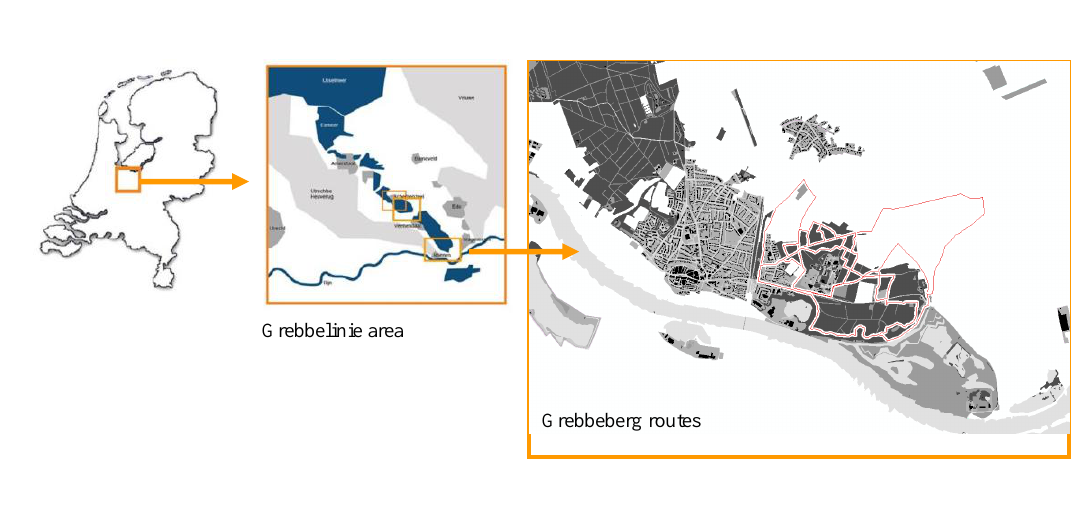
Figure 3. Location of the Grebbeberg site (right) in the Grebbelinie area (middle), The netherlands